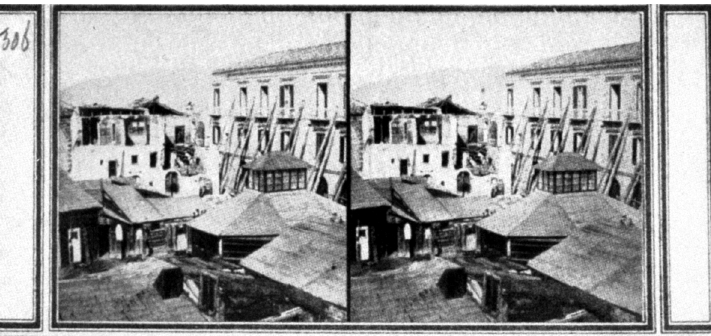
Fig. 5. Damage to the Palace of Intendenza (on the top in the right corner) according to the Mallet’s report (Mallet, 1862, stereoscopic photo no. 306). Huts are also evident in the foreground.